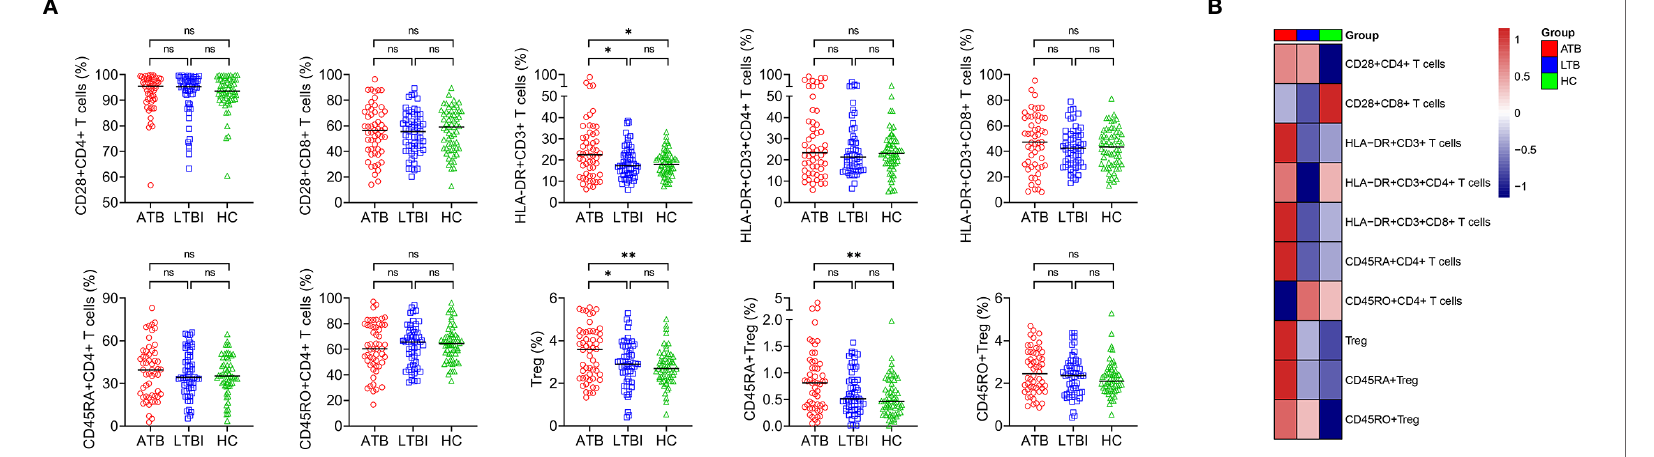
FIGURE 3 | The results of lymphocyte phenotype in ATB, LTBI, and HC. (A) Scatter plots showing the results of lymphocyte phenotype in ATB (n = 54), LTBI (n= 57), and HC (n = 60). Horizontal lines indicate the median. * P < 0.05, ** P < 0.01, ns, no signi fi cance (Mann-Whitney U test). (B) Heatmap showing the results of lymphocyte phenotype in ATB group, LTBI group, and HC group. Each rectangle indicates the median result of a group. ATB, active tuberculosis; LTBI, latent tuberculosis infection; HC, healthy controls.